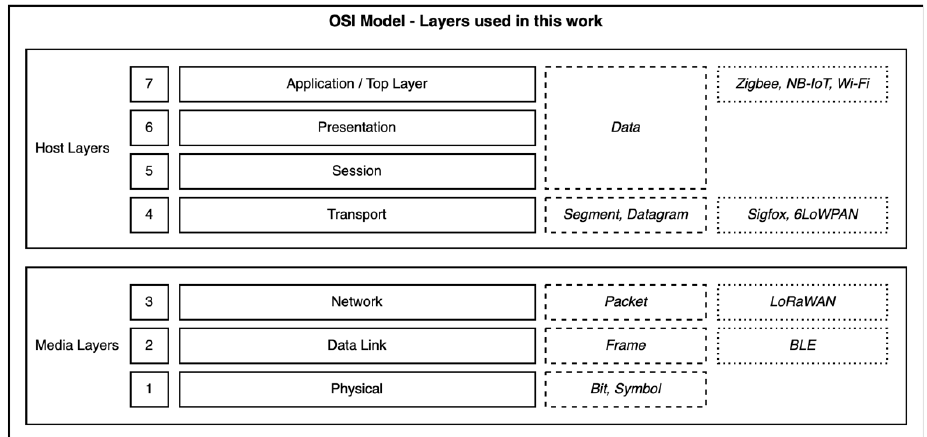
Figure 9. OSI model layer reference related to the specific layers we used with each wireless technology, showing its primary function, and data meaning and contents.